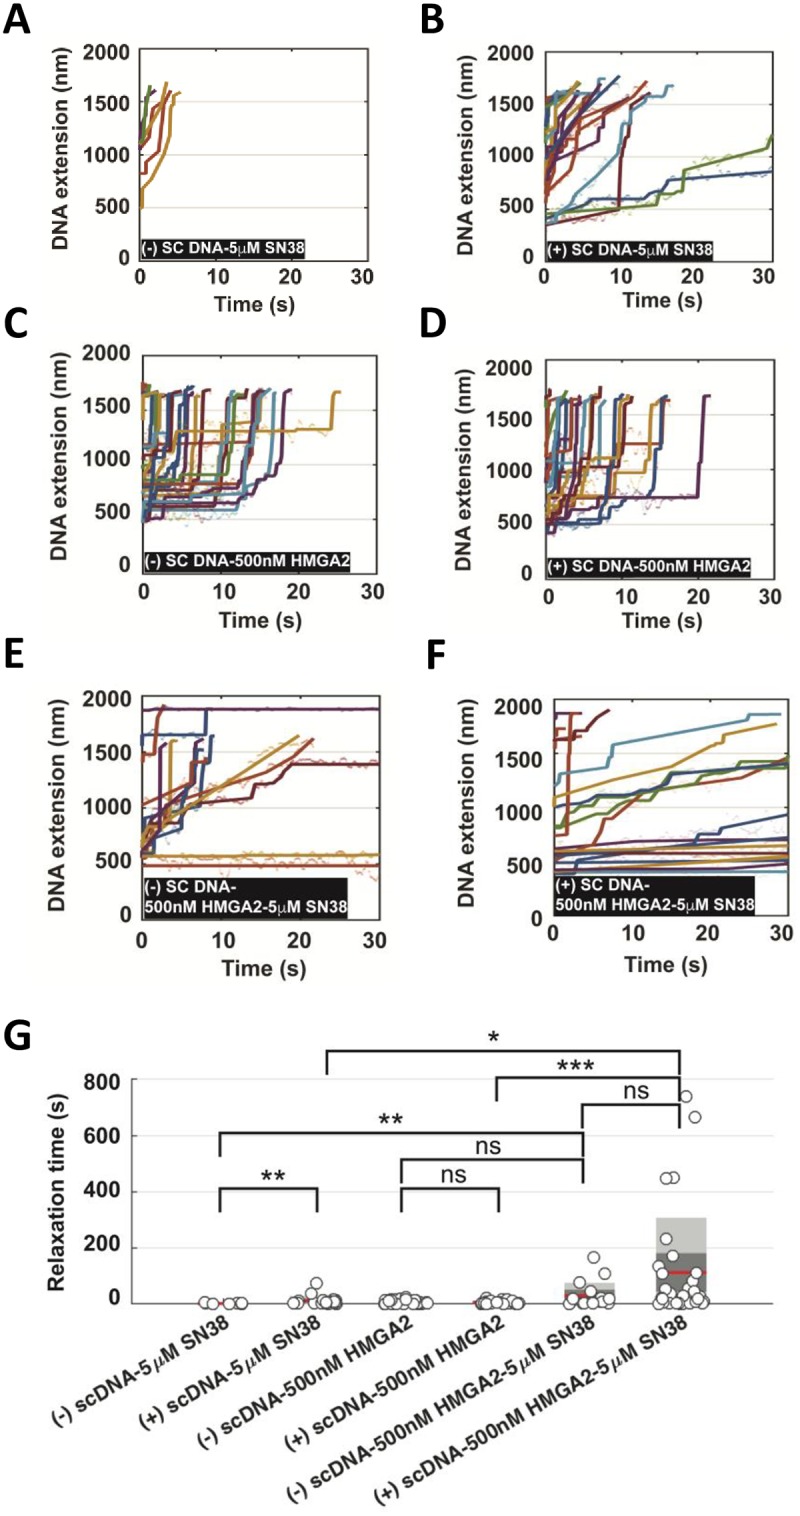
Synergistic effects of SN38 and HMGA2 on supercoil relaxation by human topoisomerase I.(A-B) In the presence of 5 nM TOP1 and 5 μM SN38, fast relaxation of (-) scDNA and slow relaxation of (+) scDNA are observed indicated by segmented extension increases linearly. The scatter plot of the raw data is fitted by piecewise linear regression (also see S4 Fig). (C-D) In the presence of 5 nM TOP1 and 500 nM HMGA2, both (-) scDNA and (+) scDNA are relaxed in a jump-pause manner for a similar duration. (E-F) In the presence of 5 nM TOP1, 5 μM SN38 and 500 nM HMGA2, many of the relaxation events are greatly impeded. The mixed features of extension increase (linear and pause-jump) can be observed. (G) Box plot of relaxation time (grey circle) summarized from (A-F). The mean is shown by the red line, grey and dark grey areas represent the distribution of SD and SEM. p-value is calculated by Wilcoxon rank-sum test. A different scale of the same plot is shown in S4 Fig. in order to highlight the different relaxation times due to the sole presence of either SN38 or HMGA2.